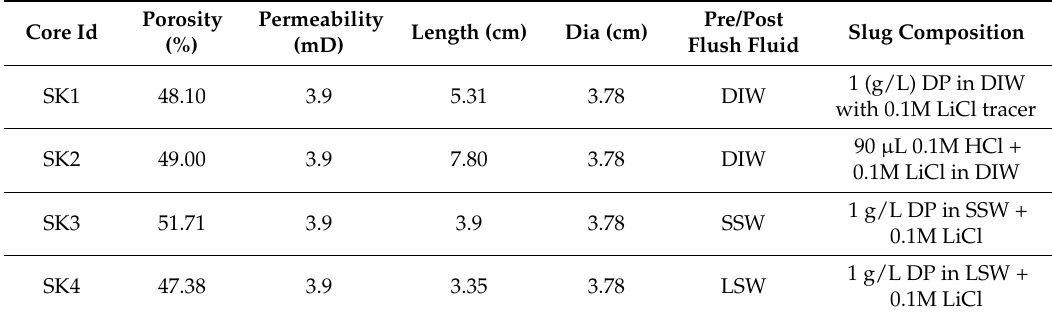
Table 3. List of experiments to test dynamic adsorption of nanoparticles (NPs) in